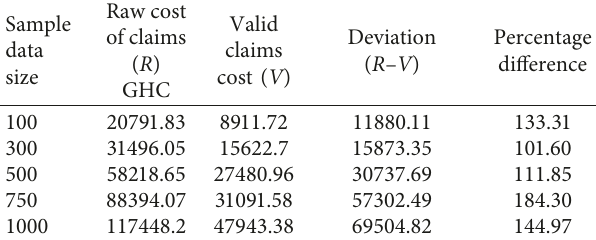
Table 6: Cost analysis of tested claims